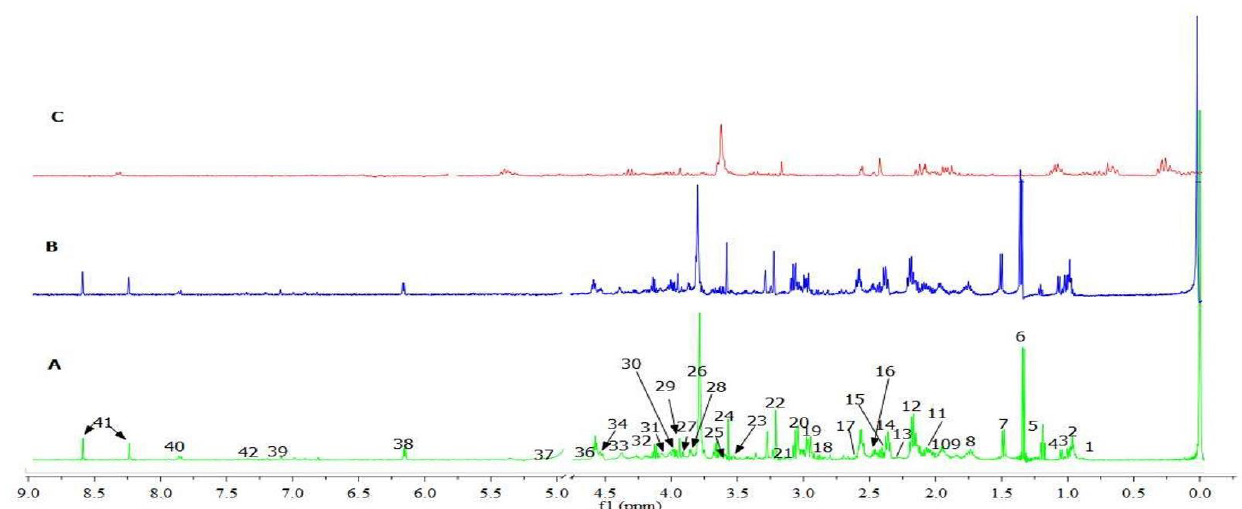
Figure 1. 1 H-NMR spectra (500 MHz, CPMG) of untreated uRBCs-control ( A ), uRBCs-AG ( B ), and uRBCs-CQ ( C ). The 1 H-